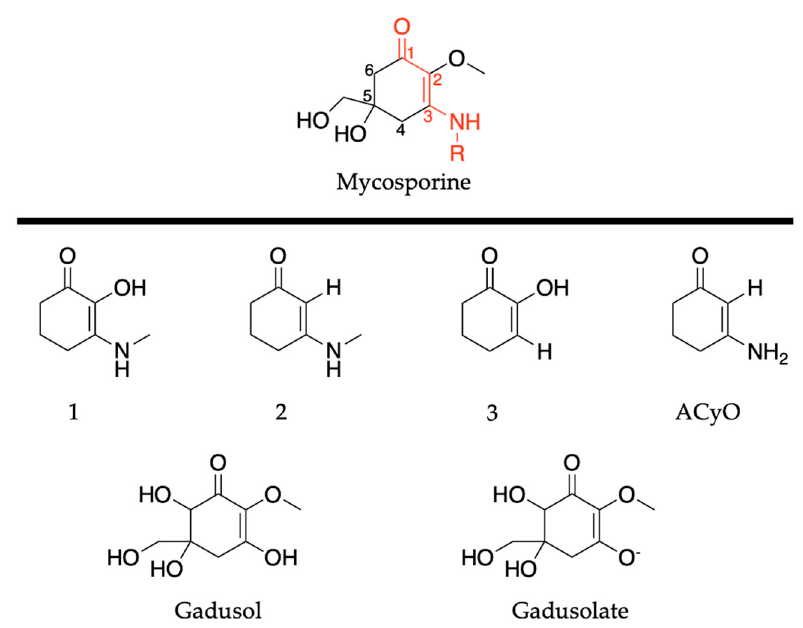
Figure 10. Structures of mycosporine motifs studied by Losantos et al. [89] and Woolley et al. [85], and gadusol/gadusolate studied by Losantos et al. [87].